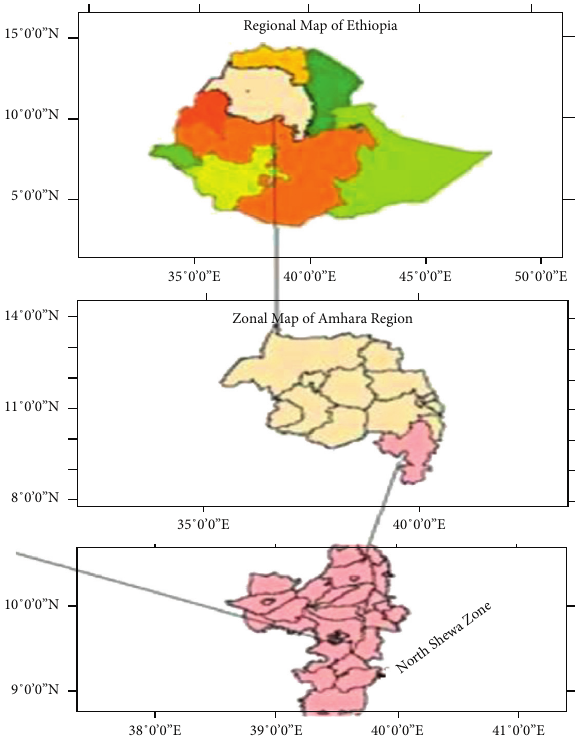
Figure 1: Geographical Location of North Shewa zone; source: Fikire